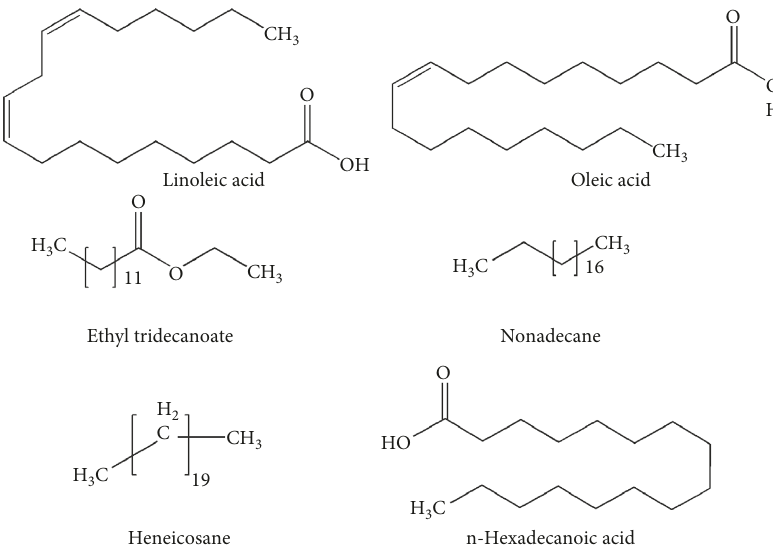
Figure 5: The most abundant compounds detected by GC-MS